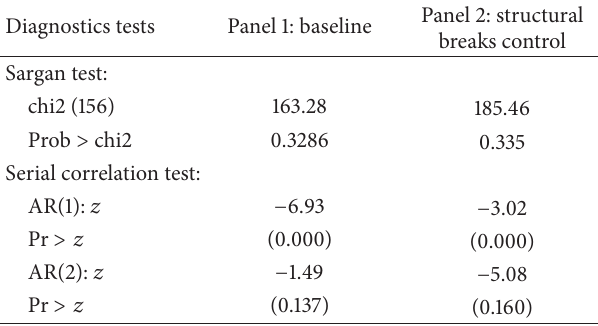
Table 2: Diagnostic tests.